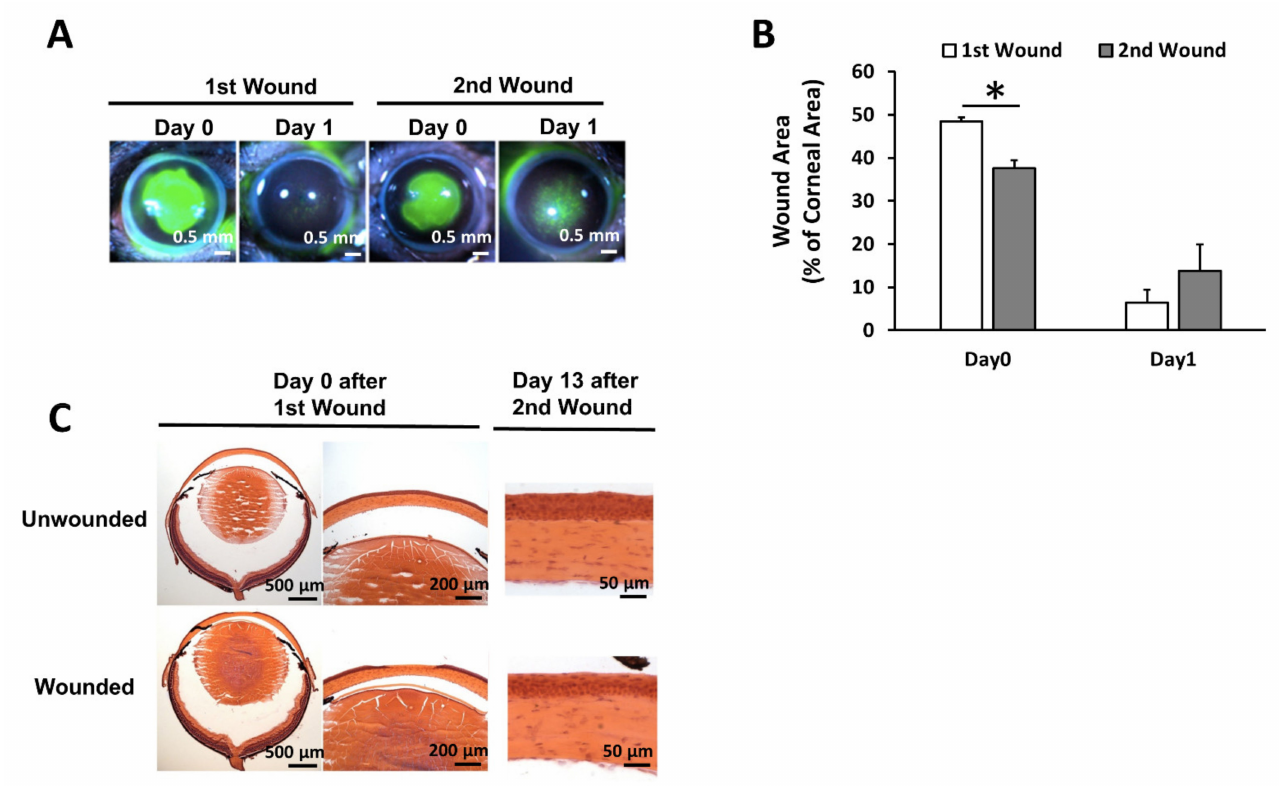
Figure 4. Repetitive wound healing procedure led to a delayed epithelial wound closure. ( A ) Repre- sentative pictures showing the corneal epithelial wound which was not covered by functional corneal epithelial cells after the first and second wounds using fluorescein staining. ( B ) Quantitation on the percentage of wound area after the first and second wounds. Percentage of wound area was calcu- lated as the wound area revealed by fluorescein staining/the corneal area. *: p < 0.05. ( C ) Histological pictures showing that the repetitive epithelial wounding did not cause obvious damage to the stroma and the wound healed without an obvious scar. The tissue sections were stained with